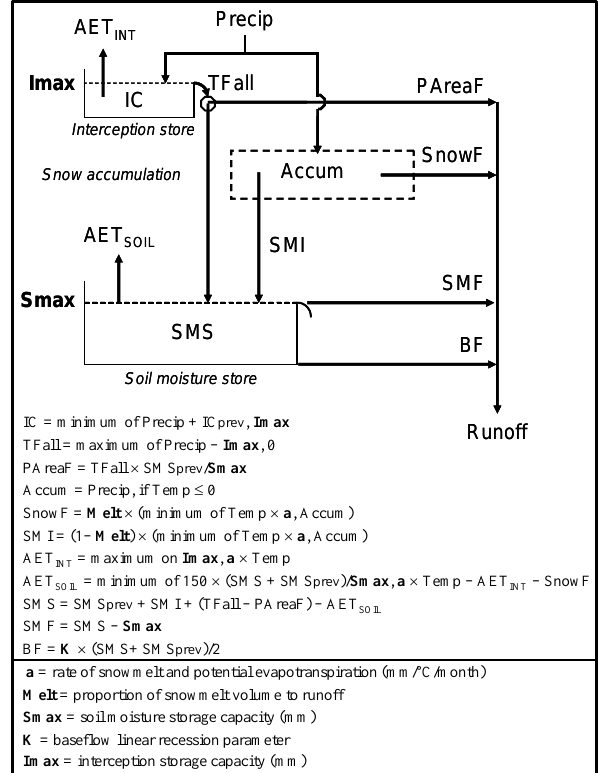
Figure 2. Structure of the monthly conceptual precipitation– evapotranspiration–runoff model (PERM) where the five calibration parameters are highlighted in